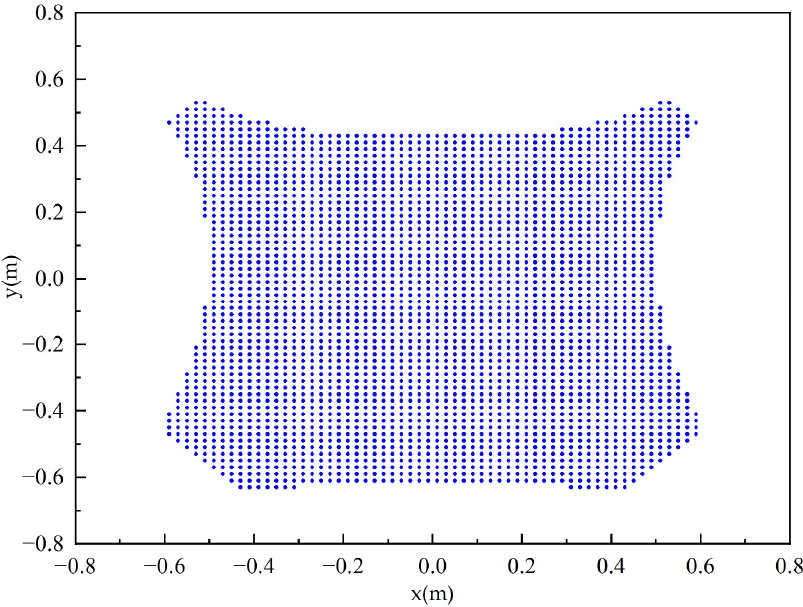
Figure 7. The force-feasible workspace of the four-cable-driven parallel mechanism.